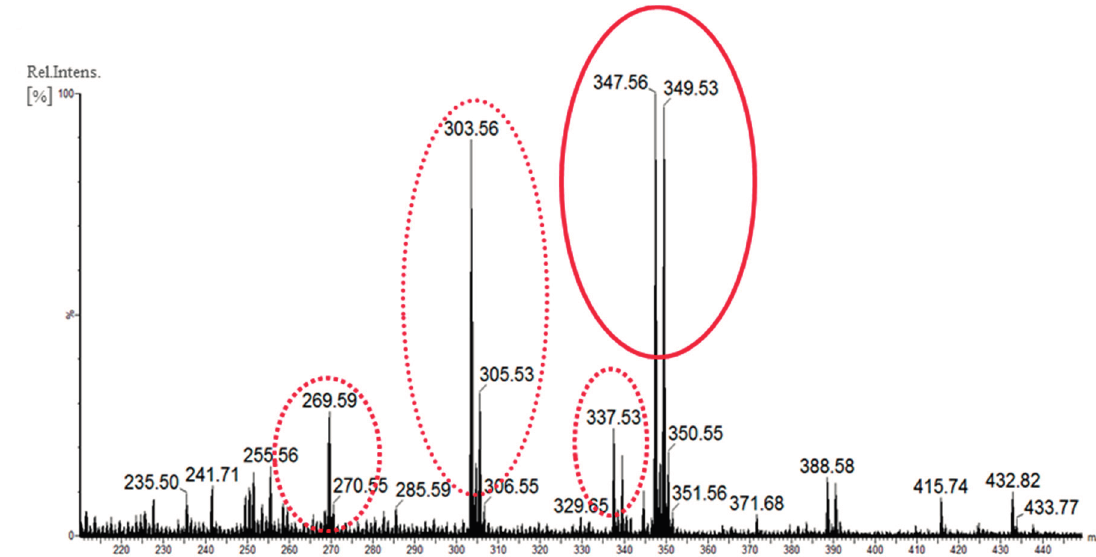
Figure 5. Full scan spectrum of the crude extract obtained from T. wortmannii cultivated in PD medium with HBr as additive. Pseudomolecular ions from the co-produced rugulovasines and chlorinated analogues are highlighted in dashed line, while the brominated detected species is highlighted in continuous line. Data acquired at ESI+, triple quadrupole MS